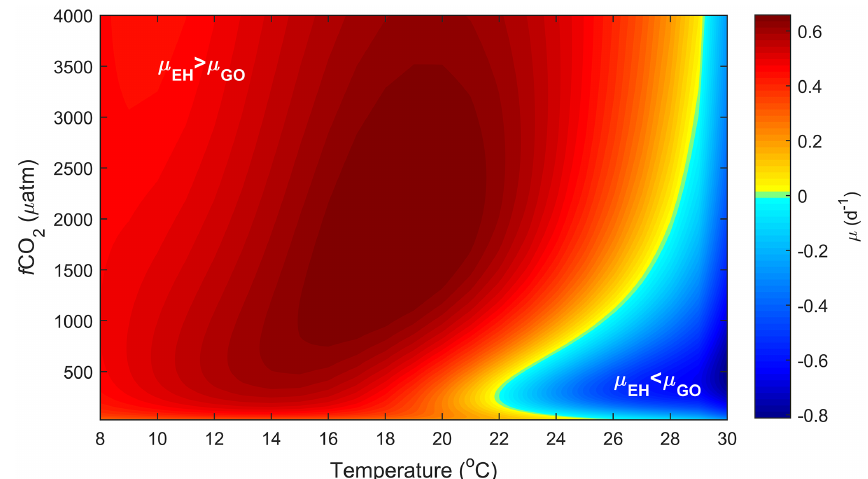
Figure 5. Predicted difference in growth rates between E. huxleyi and G. oceanica across a temperature range of 8–30 ◦ C and a f CO 2 range of 25–4000µatm at 150µmolphotonsm − 2 s − 1 of light based on Eq. (2).